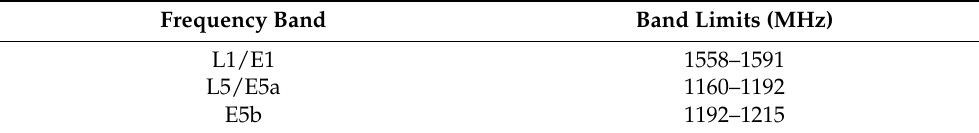
Table 1. L1/E1, L5/E5a and E5b frequency band limits used in the analysis. Frequency